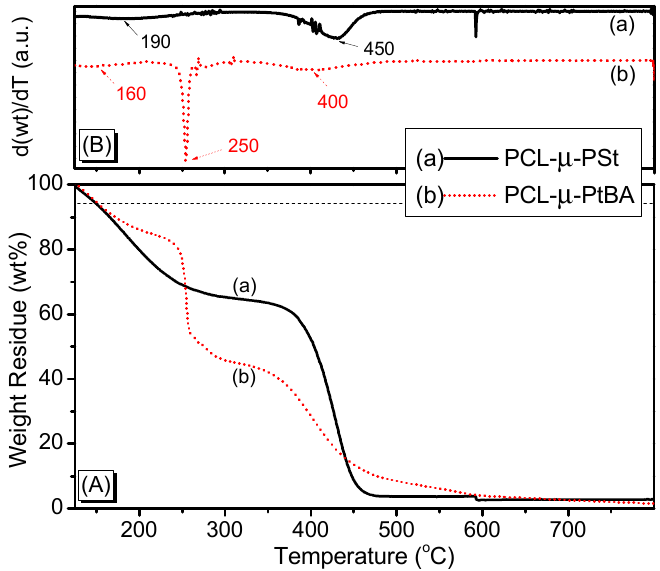
Figure 8. TGA ( A ) and DTGA ( B ) traces of ( a ) PCL- μ -PSt and ( b ) PCL- μ -PtBA star copolymers. Table 1. Summary of thermal properties of μ -star copolymers.